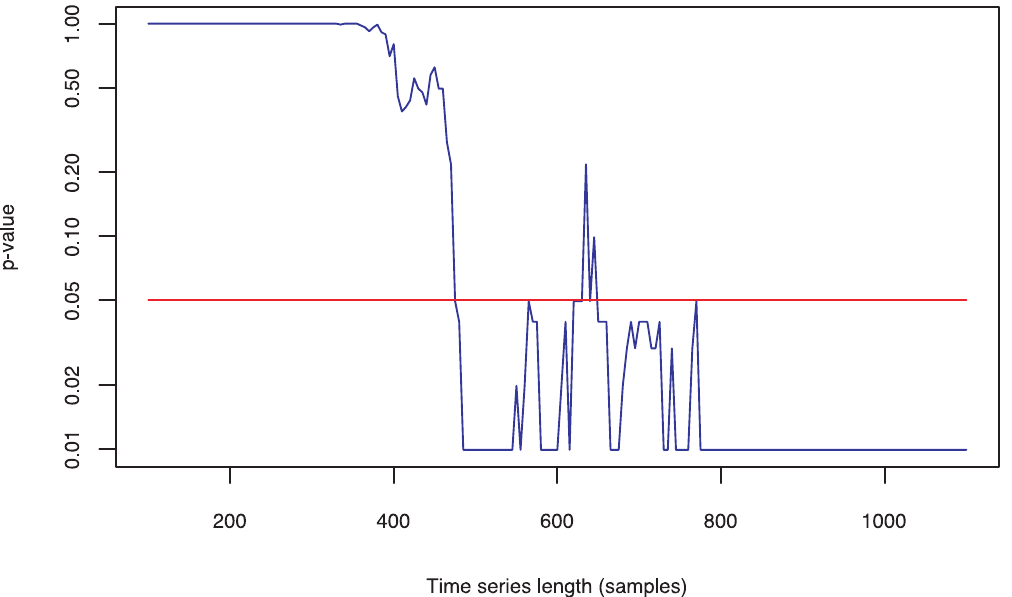
Figure 4. Semi-log plot of p -value against series length for a single time series that passes the zeroth surrogates test for nonlinearity. Each p -value was calculated using 100 surrogates. Signs of nonlinearity are not detected until the length of series being tested is greater than 400 samples. P-values do not drop to show significant nonlinearity, which is marked with a red line, until the time series is approximately 500 samples long.